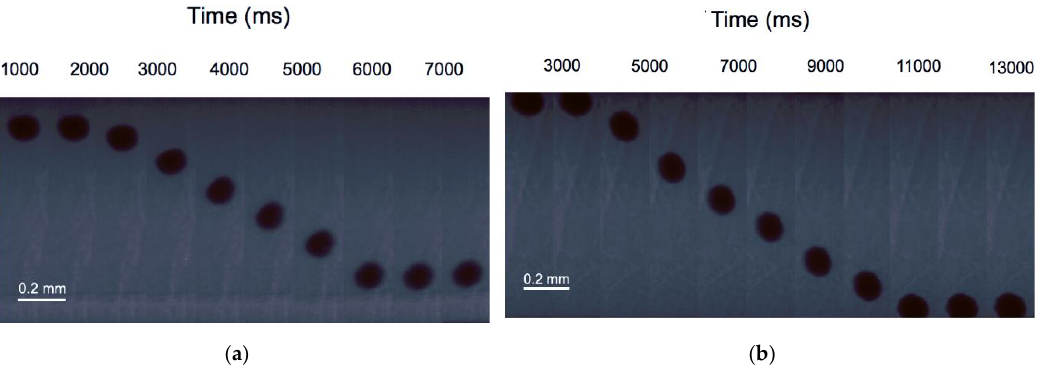
Figure 1. X-ray radiography images of the Pt sphere falling in runs ( a ) FOID1_RUN2 (4.7 GPa/1755 °C) and ( b ) FOID2_RUN2 (3.4 GPa/1360 °C) as function of time.